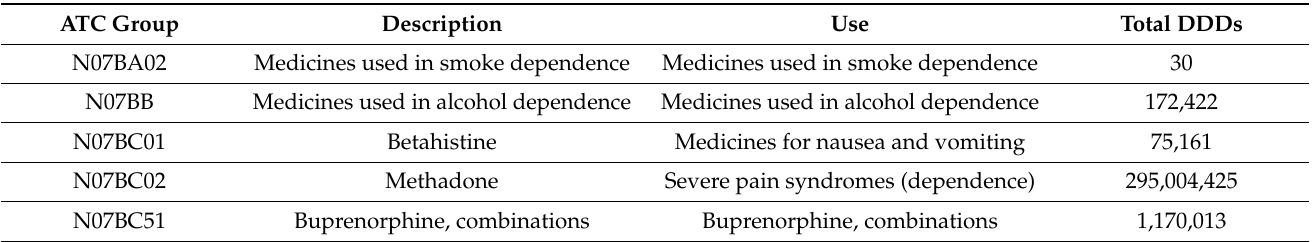
DDD = defined daily dose; ATC = Anatomical Therapeutic Chemical classification. Table 7. Total DDDs for ATC subgroup N07B (males + females). ATC Group